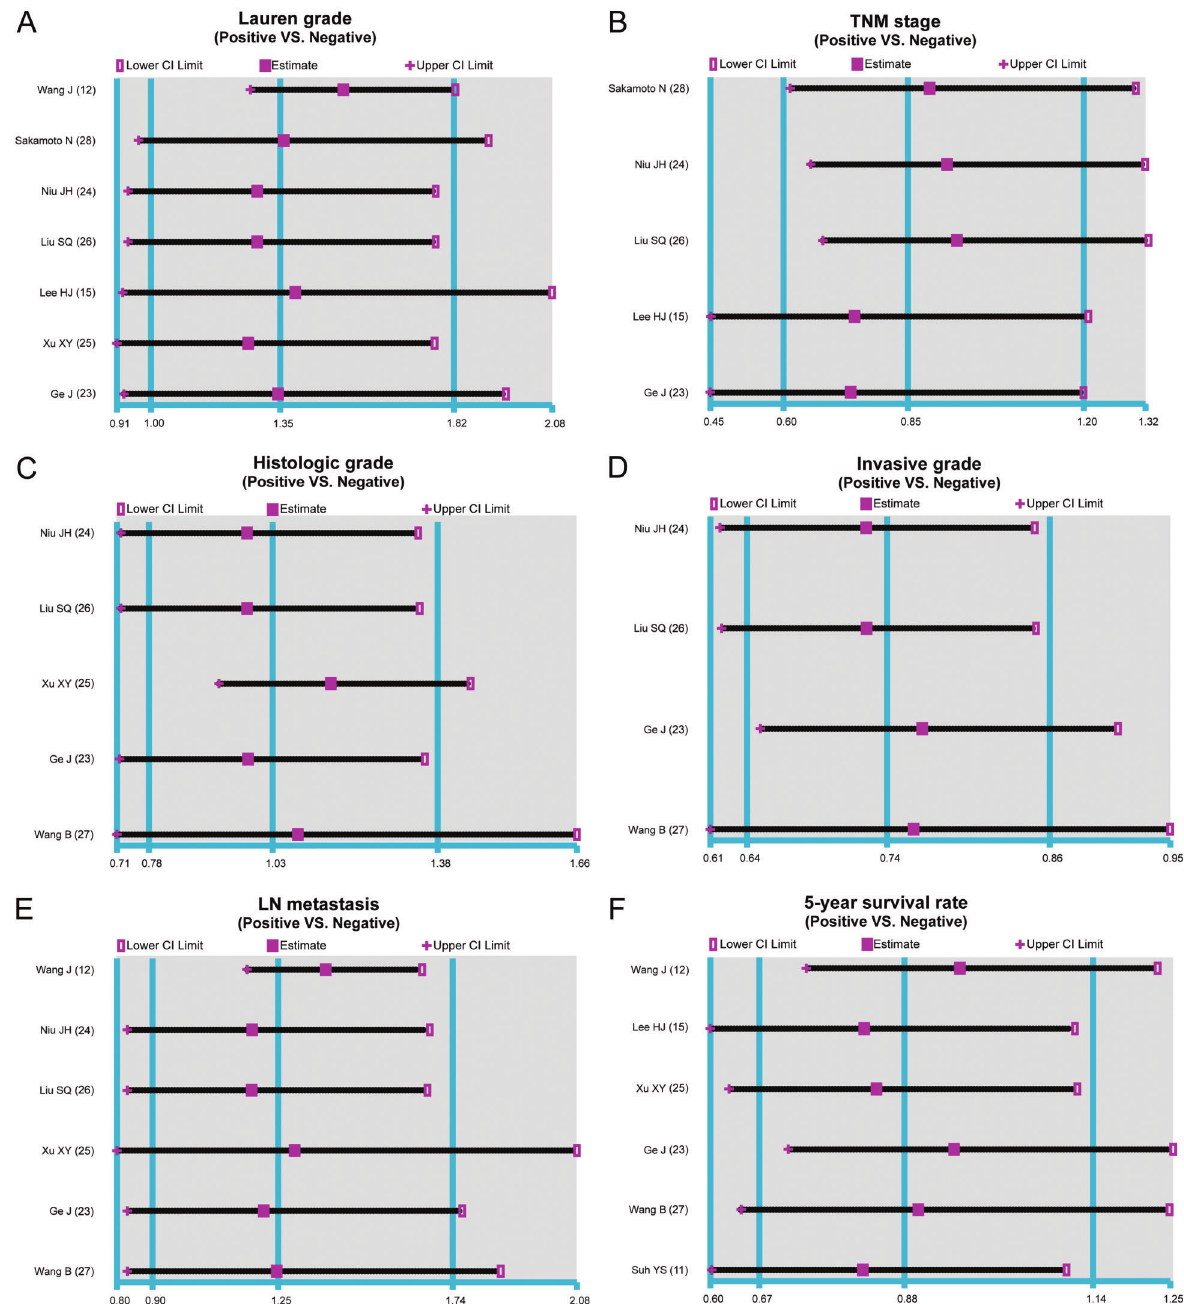
Figure 4. Sensitivity analyses of the correlation between cadherin-17 (CDH17) protein expression and the prognosis of patients with gastric cancer